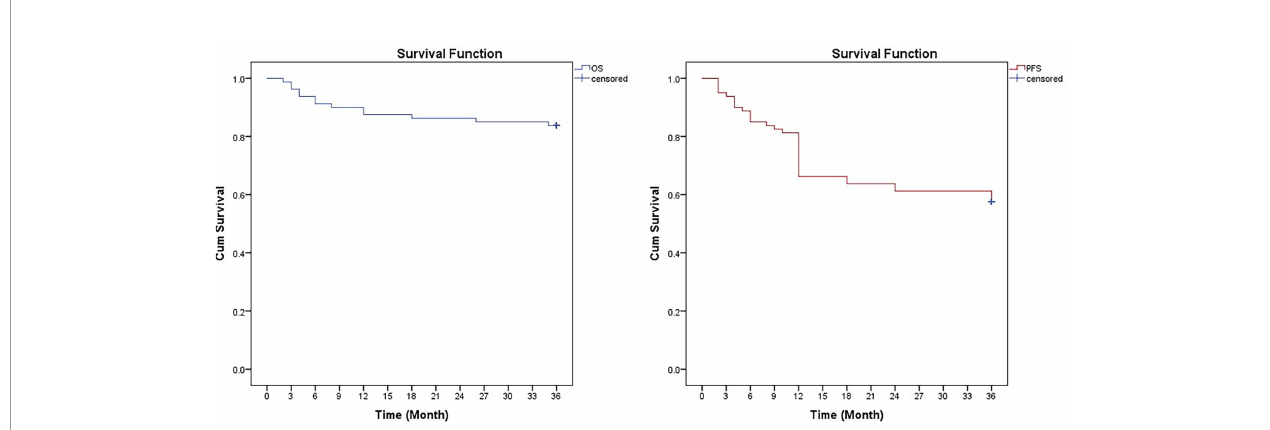
FIGURE 3 | Kaplan-Meier curves for overall survival (OS) and progression-free survival (FPS) in 80 children with high-risk neuroblastoma treated with